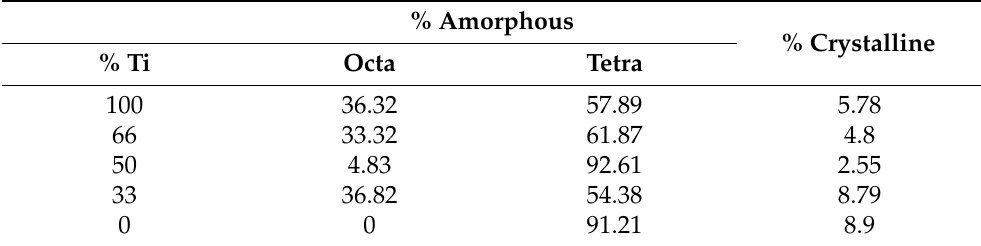
Table 6. Ratios among octahedral, tetrahedral, and crystalline active